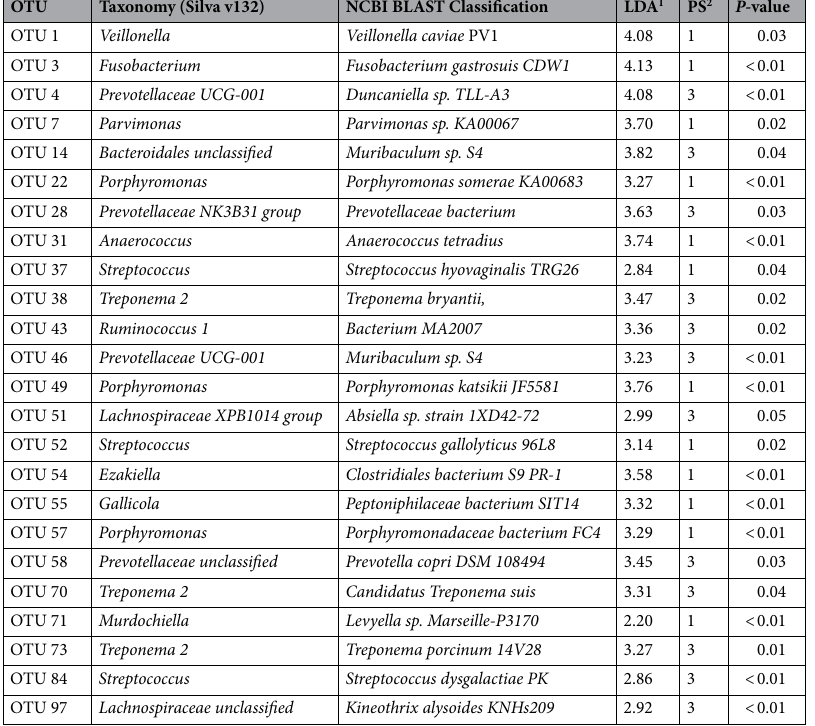
Table 1. Differences in OTUs between vaginal microbiomes of PS1 and PS3 sows. Individual microbes were assigned in ordered of abundance and classified into operational taxonomic units (OTUs). 1 Linear discriminate analysis (LDA) was used for comparison between perineal scores. 2 Sows were assigned a perineal score (PS) based on their relative risk of experiencing a pelvic organ prolapse (POP). Sows assigned PS1 were presumed low risk for POP while sows assigned PS3 were presumed high risk for POP.